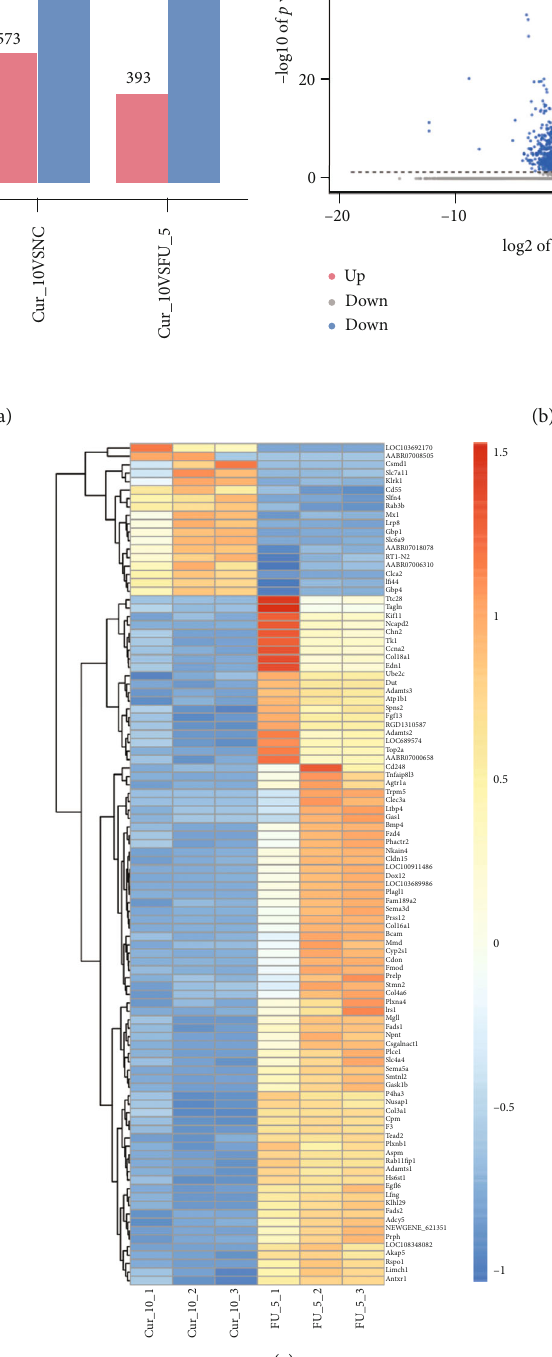
Figure 5: RNA-sequencing and identi fi cation of DEGs in curcumin-treated IEC-6 cells. (a) Identi fi cation of DEGs between the tested groups according to the thresholds of p < 0 : 05 and ∣ logFC ∣ >1 . (b) Volcano plot of the identi fi ed DEGs between the 5-FU and 5-FU+ curcumin groups. Blue plot represented downregulated DEGs; red plot represented upregulated DEGs. (c) Cluster analysis of the top 100 DEGs. 5- FU: 5- fl uorouracil; Cur: curcumin; DEGs: di ff erentially expressed